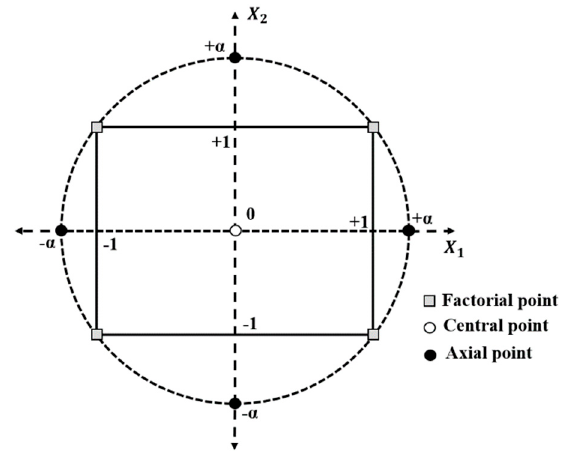
Figure 7. Central composite design for two design variables at two levels (Jung et al., 2016).